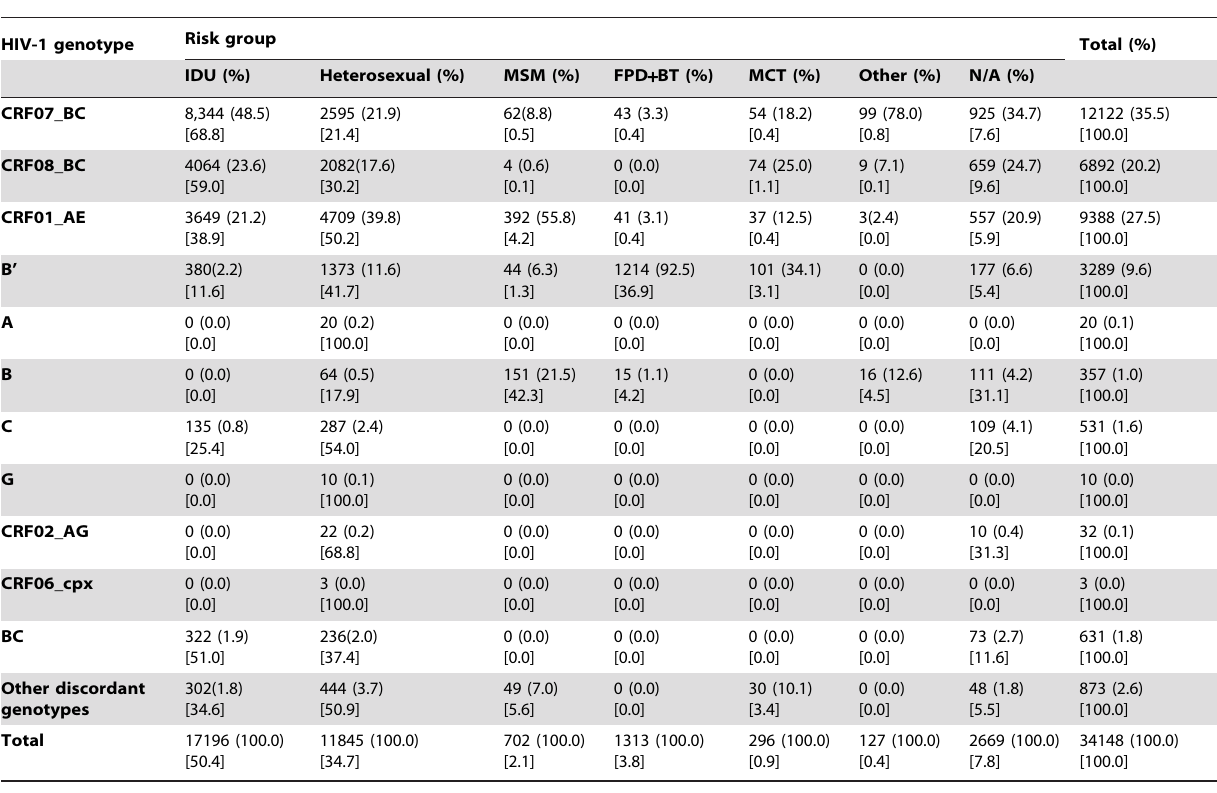
Table 2. Distribution of HIV-1 genotypes in different risk groups in China * .